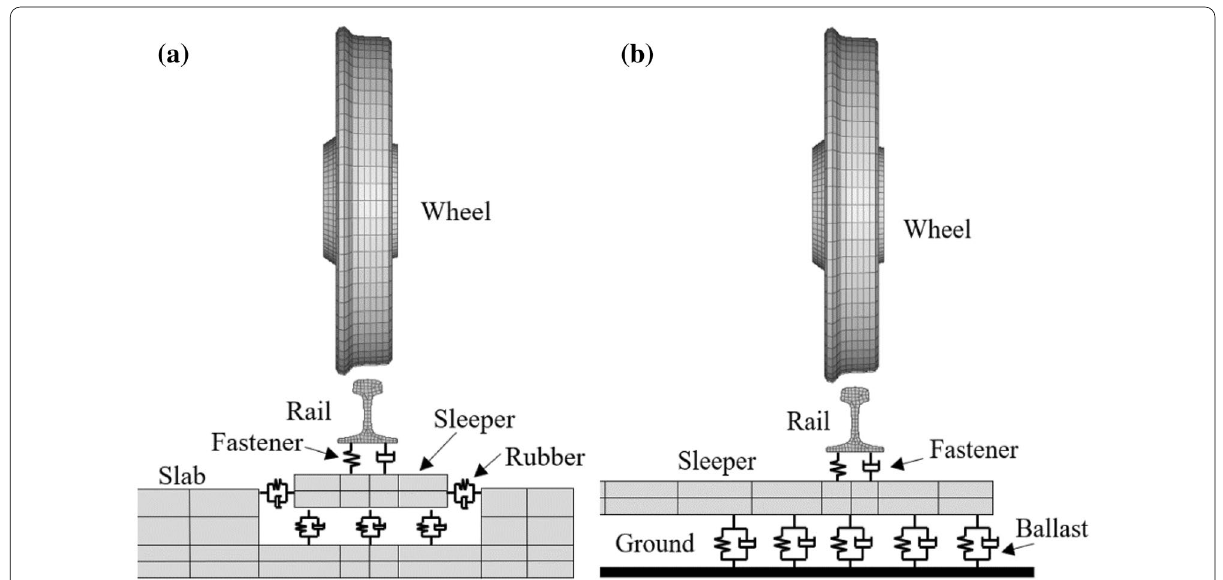
Figure 15 Simulation model: ( a ) Rubber-booted short sleeper track and ( b ) Ballast